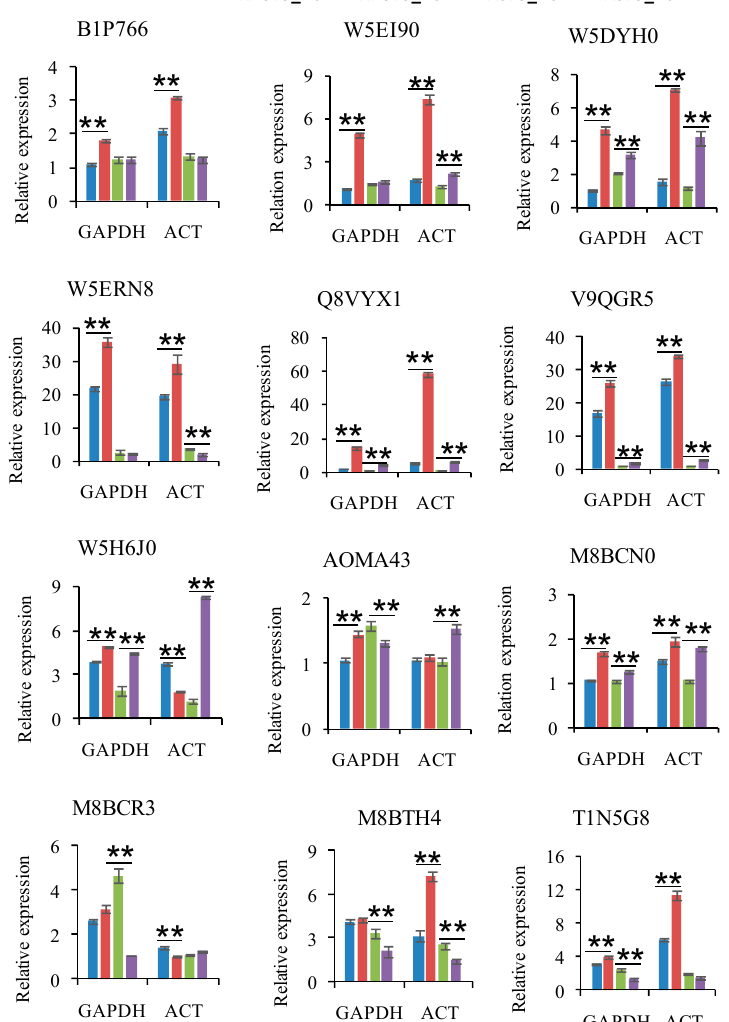
Figure 3. Relative mRNA expression analysis of twelve differentially abundant proteins (DAPs) using real-time PCR under drought stress (DS) and no stress (NS) conditions. Each bar shows the mean ± standard errors (SE) of three biological replicates. Two independent trials were conducted using TaGAPDH ( GAPDH ) and TaActin ( ACT ) as reference genes, respectively. The relative expression levels of each gene were calculated using the formula 2 − ∆∆ Ct (* P ≤ 0.05; ** P ≤ 0.01, Duncan’s multiple range test).